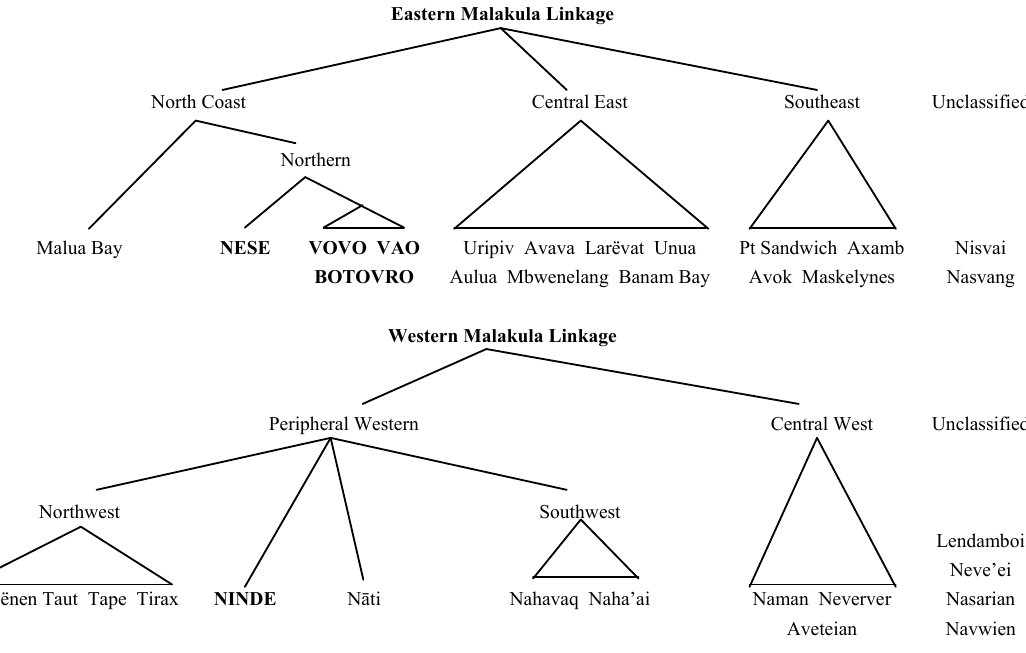
Figure 1: Tentative Malakula